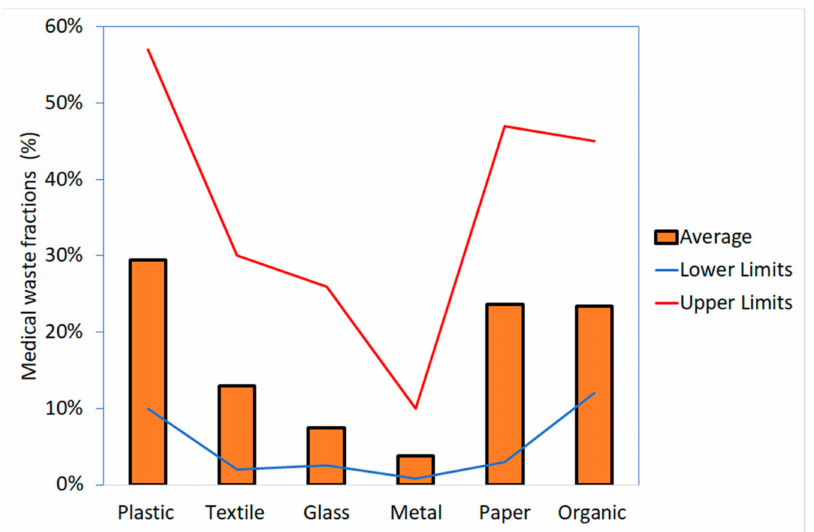
Figure 2. Average values, upper limits, and lower limits of the main medical waste